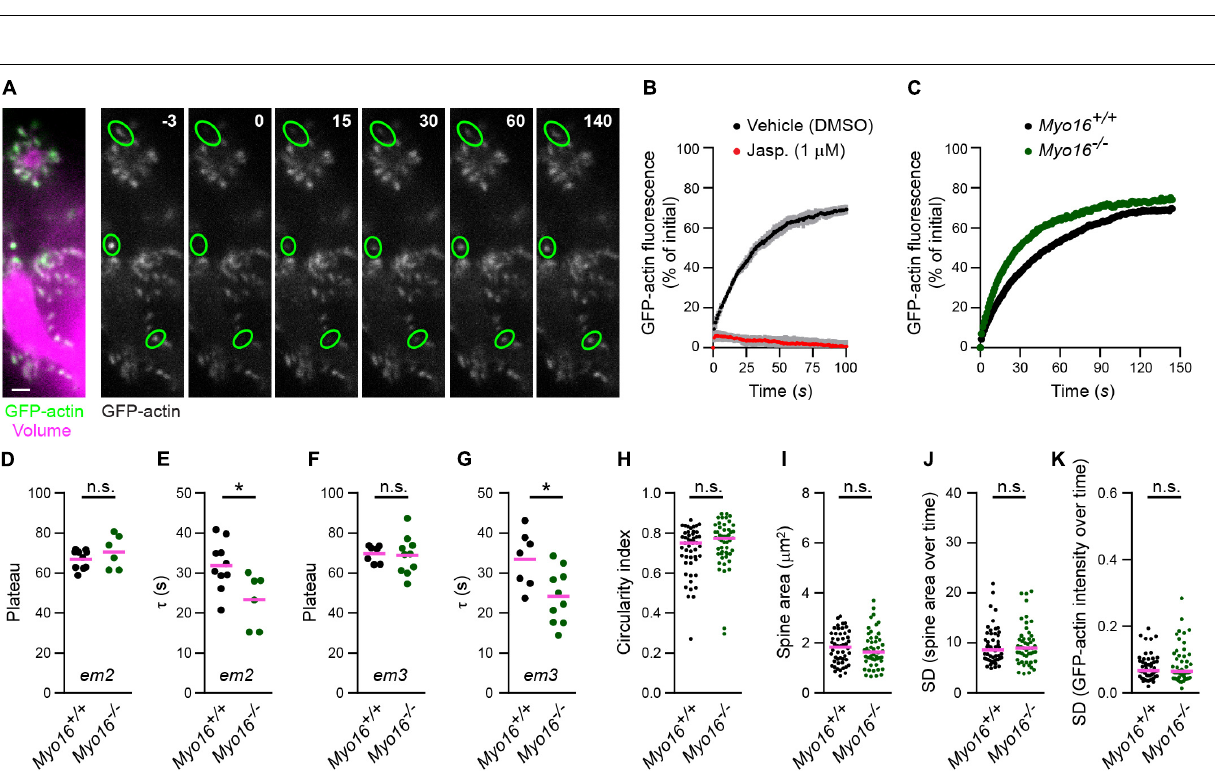
FIGURE 3 | Myo16 knockout leads to accelerated F-actin turnover in Purkinje cell dendritic spines. (A) FRAP analysis of GFP-actin in PC spines. Left, Dendrite branches of a live PC at 14 DIV, co-transfected with L7/Pcp-2 promoter plasmids encoding GFP-actin (green) and volume marker FusionRed (magenta). Shown is an image recorded using spinning disk confocal microscopy. Scale bar, 2 µ m. Right, Example of a FRAP experiment. Images of GFP-actin taken before and after bleaching are shown, time is indicated (seconds). Green ovals highlight bleached spines. Images correspond to frames of a time-lapse movie ( Supplementary Movie S4 ). (B) FRAP analysis of GFP-actin in spines of PCs treated with 1 µ M jasplakinolide (Jasp.; red) or with vehicle (0.1% [v/v] DMSO; black). Cells were co-transfected with L7/Pcp-2 promoter plasmids encoding GFP-actin and volume marker as in (A) . Graph depicts recovery of GFP-actin fluorescence intensity in spines over time (s) relative to the bleached fluorescence intensity. Data points represent mean ( n = 3 independent experiments per condition) ± SD (gray). (C) FRAP analysis of GFP-actin in spines of Myo16 em 2 knockout PCs ( Myo16 − / − ) and Myo16 + / + littermate PCs co-transfected as in (A) . Graph depicts recovery of GFP-actin fluorescence intensity in spines, data points represent the mean of a representative experiment (see section “Materials and Methods”). (D) GFP-actin FRAP recovery plateau in spines of Myo16 em 2 knockout PCs ( Myo16 − / − ) and Myo16 + / + littermate PCs. Data show plateau values obtained as described in section “Materials and Methods” from independent experiments ( n = 6–10; magenta line indicates mean); p value determined using Student’s t -test. (E) GFP-actin FRAP recovery time constant ( τ ) in spines of Myo16 em 2 knockout PCs ( Myo16 − / − ) and Myo16 + / + littermate PCs. Data are τ values obtained as described in section “Materials and Methods” from independent experiments ( n = 6–10; magenta line indicates mean); p value determined using Student’s t -test. (F,G) As in (D,E) , but using Myo16 em 3 knockout PCs ( Myo16 − / − ) and Myo16 + / + littermate PCs ( n = 7–10). (H) Circularity index of spines of Myo16 em 2 knockout PCs ( Myo16 − / − ) and Myo16 + / + littermate PCs expressing GFP-actin and volume marker. Value of 1.0 corresponds to perfectly circular shape, lower values indicate elongated shape. Data points represent single spines, magenta line indicates median; p value determined using Mann–Whitney test. (I) Apparent area covered by single spines of Myo16 em 2 knockout PCs ( Myo16 − / − ) and Myo16 + / + littermate PCs expressing GFP-actin and volume marker. Data points represent single spines, magenta line indicates median; p value determined using Student’s t -test. (J) Spine area changes over time of Myo16 em 2 knockout PCs ( Myo16 − / − ) and Myo16 + / + littermate PCs expressing GFP-actin and volume marker. Data points represent standard deviation (SD) of the relative area change of single spines over 150 s, magenta line indicates median; p value determined using Mann–Whitney test. (K) Change of GFP-actin fluorescence intensity over time in spines of Myo16 em 2 knockout PCs ( Myo16 − / − ) and Myo16 + / + littermate PCs expressing GFP-actin and volume marker. Data points represent SD of the relative fluorescence change of single spines over 150 s, magenta line indicates median. For reason of comparability with the other figures, a single data point of Myo16 − / − lying above the Y -axis limit is not shown; p value determined using Mann–Whitney test. ∗ p < 0.05; ∗∗ p < 0.01; ∗∗∗ p < 0.001; ∗∗∗∗ p < 0.0001; n.s., not significant.